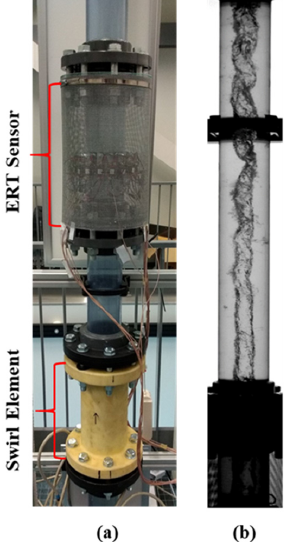
Table 1. Properties of the solutions tested during the calibration experiments.